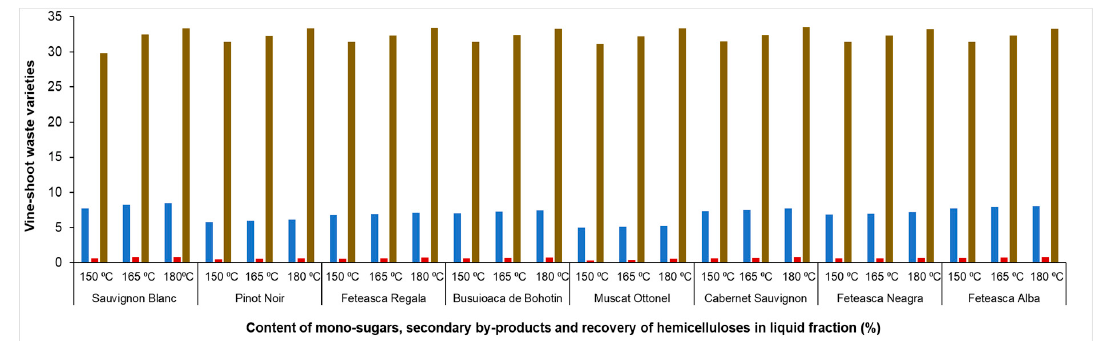
Figure 3. Recovery of hemicellulose in the liquid fraction for autohydrolysis performed at each temperature (mono-sugars, secondary by-products and hemicellulose).